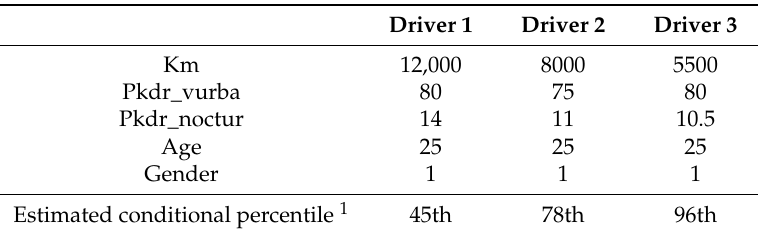
Table A3. Estimates of the conditional percentiles for drivers with di ff erent characteristics, each of whom has driven 600 km above the posted speed limit. The models used in the calculations consider Tolerkm / 1000 as the dependent variable and km_1000 (km / 1000) and km_1000 2 are introduced in the model, instead of lnkm, as independent variables.